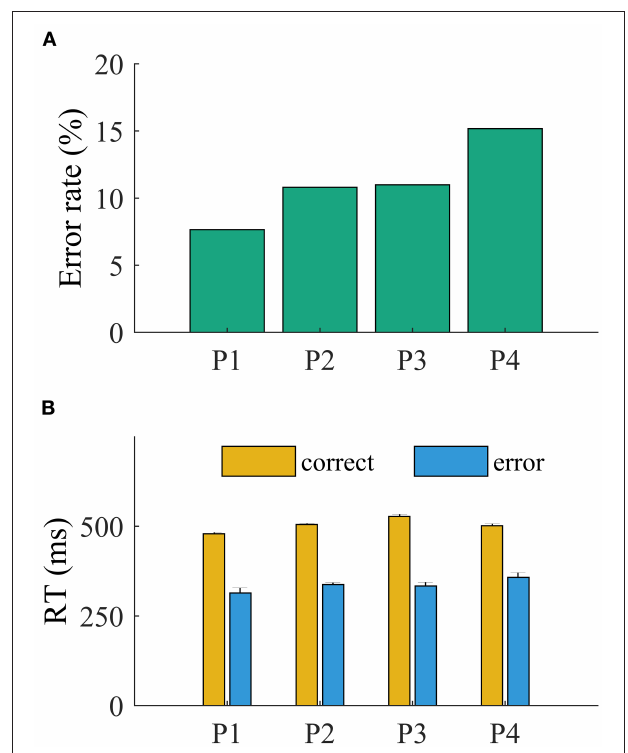
FIGURE 2 | Behavioral results. (A) Error rate and (B) overall reaction